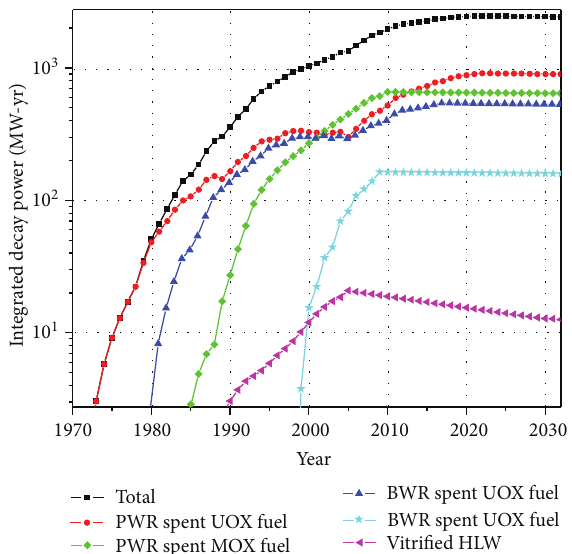
F 8: Decay power of stored nuclear material (SNF and vitri�ed HLW) integrated over the period from 100 to 2000 years aer data shown.